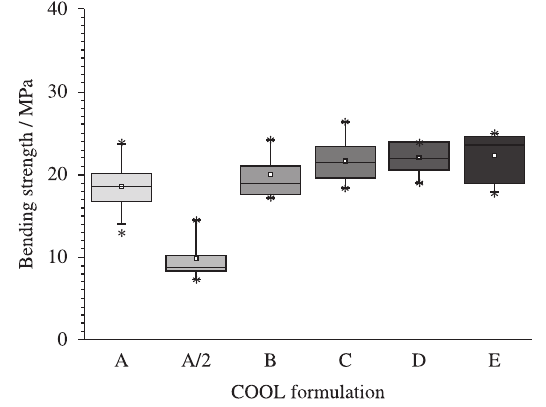
Figure 1. 4- point- bending strength according to DIN 53435 of different COOL formulations (mean ± SD, n = 6) measured after 48 hours (24 hours in H O at 37 °C, 24 hours in air at 21 °C). Statistical significant differences 2 are marked with * for p < 0.05